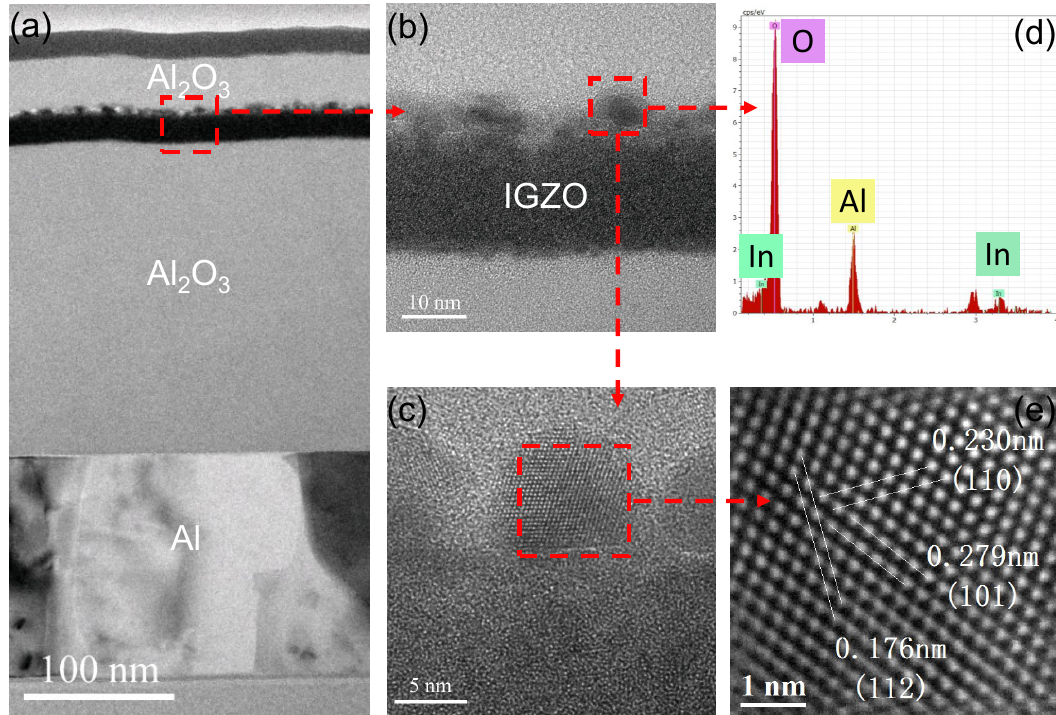
Figure 4. ( a ) cross-sectional image of a-IGZO TFT with Cu S/D and Al 2 O 3 PVL; the ( b ) 450 k and ( c ) 910 k magnified image of the interface between a-IGZO and Al 2 O 3 PVL; ( d ) corresponding EDS and ( e ) HR-TEM image of the particles.